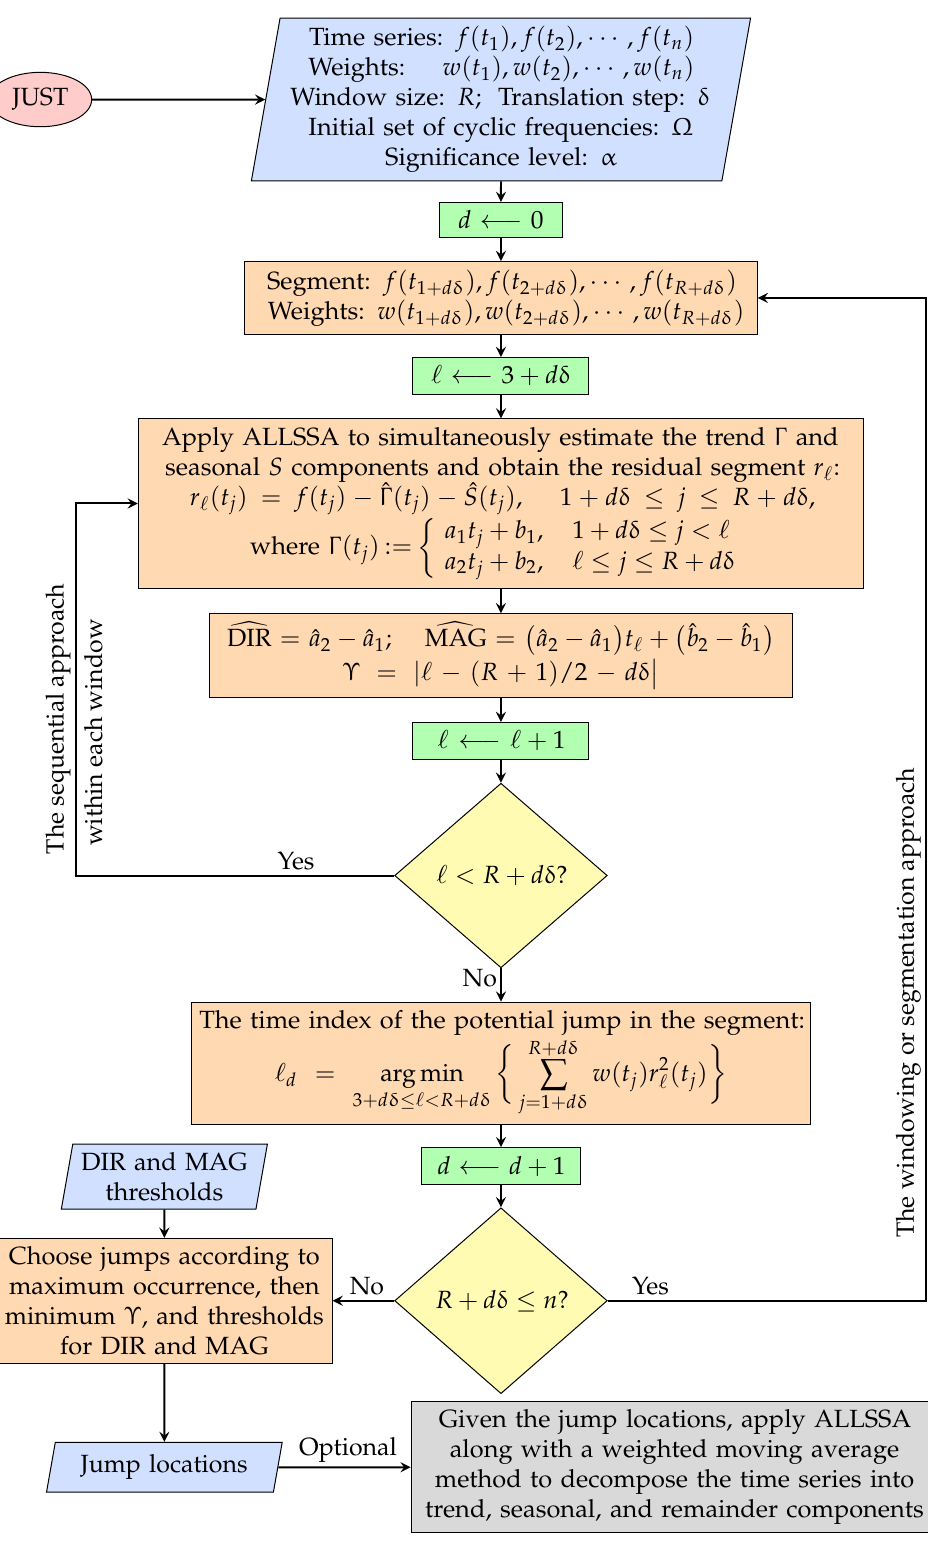
Figure 4. Flowchart of JUST. The weights are optional inputs and in general can also be entered in the form of a matrix P , the inverse of the covariance matrix associated with the time series. The constituents of known forms are the linear trends by default ( Γ ). Symbol | · | denotes the absolute value. The flowchart of ALLSSA used in JUST is in Figure 3.4 of [22], or see